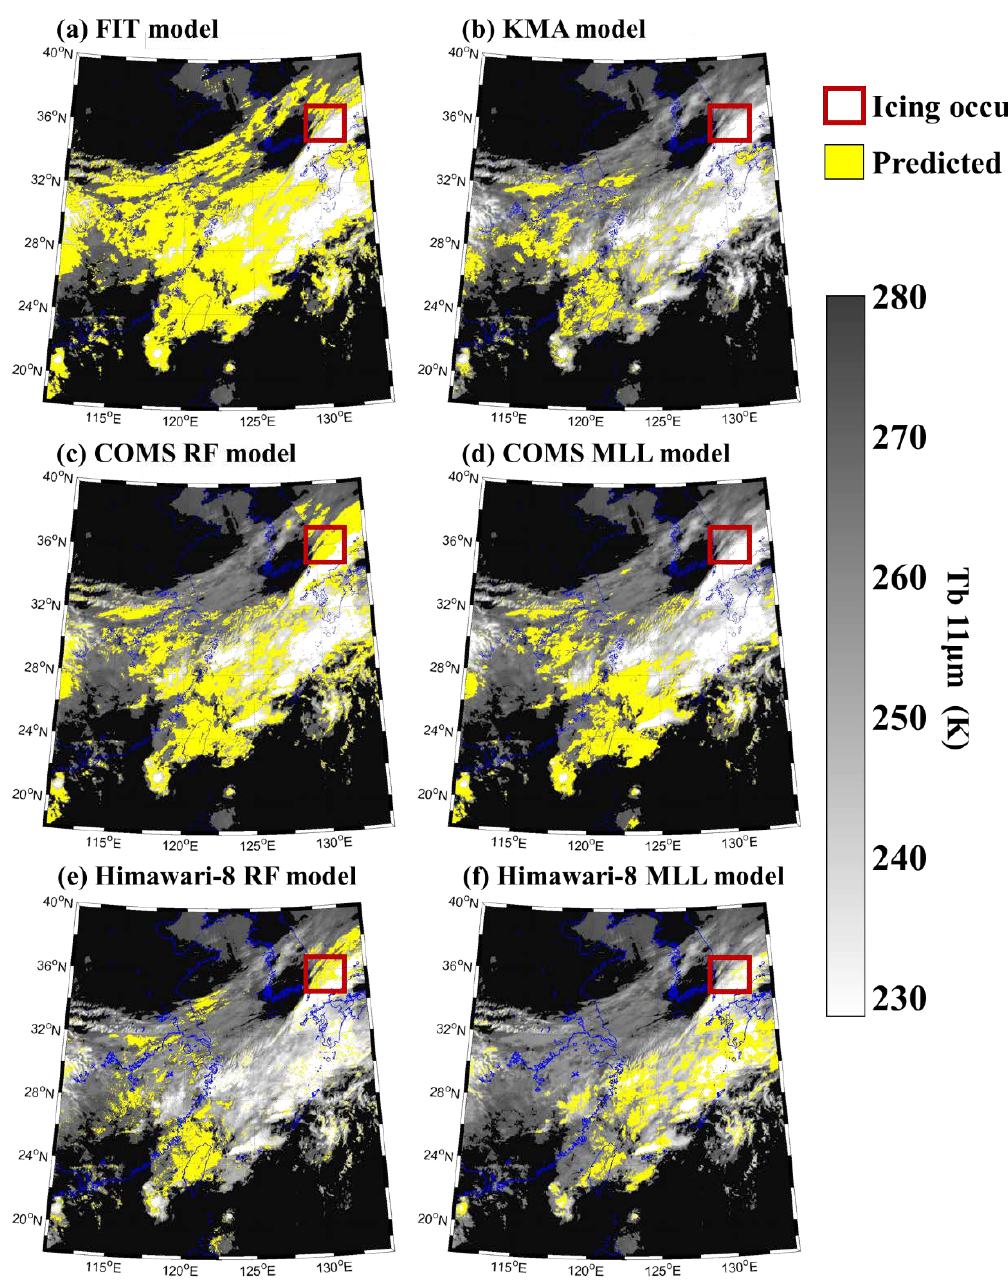
Figure 5. Maps of potential icing areas produced by the six algorithms for the COMS and Himawari-8 images collected on 24 April 2016 01:00 UTC. The 11 µ m channel Tb image ranging from 228 K to 280 K is used as the background image. Areas with no cloud or a Tb of 11 µ m > 270 K were masked out and appear black in the figures.